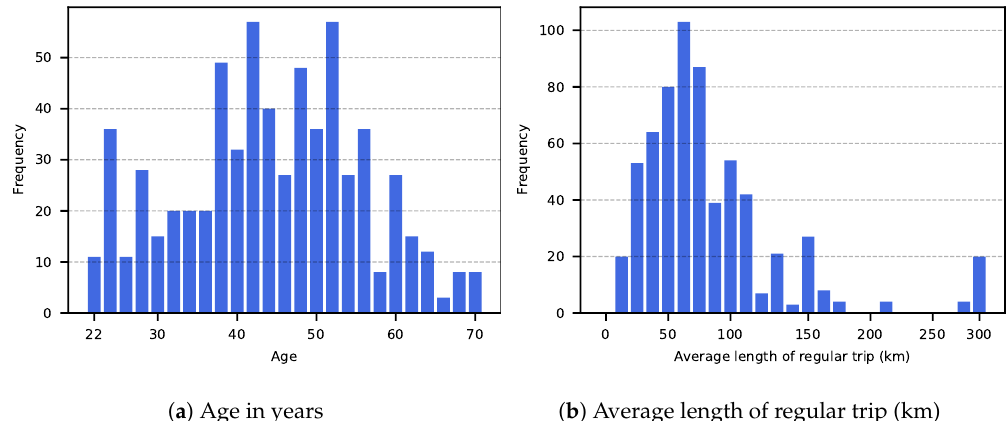
Figure 3: Distribution of vehicle types in the sample (a) and in the Netherlands (b).